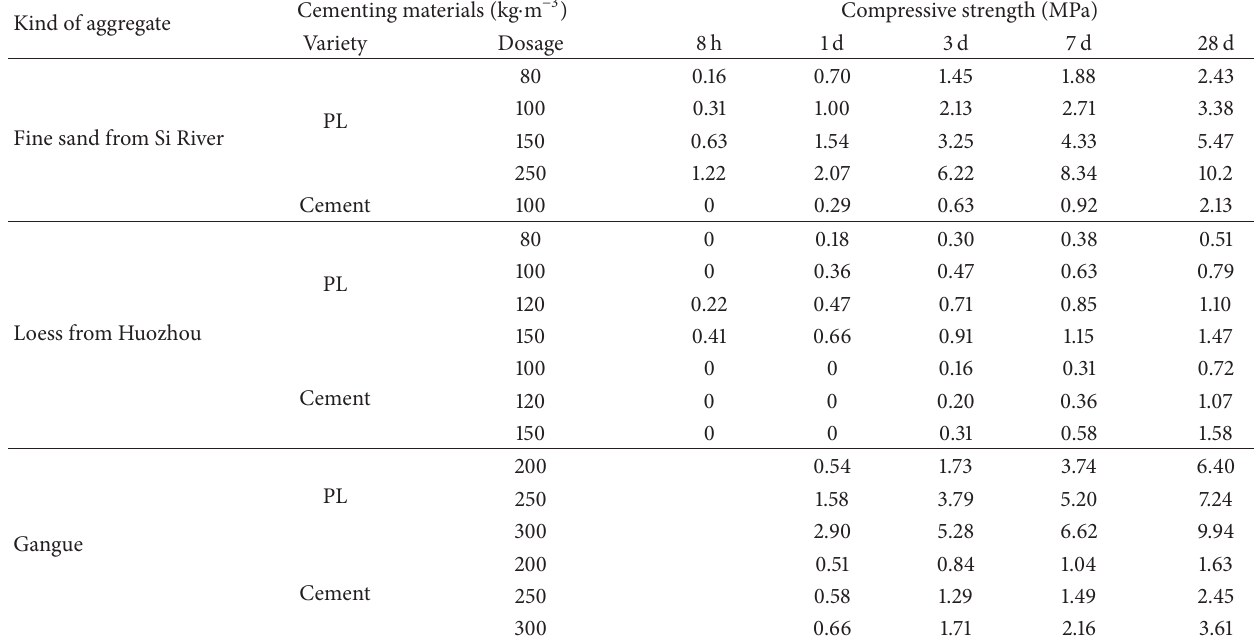
Table 1: Performance table of PL backfilling cementing materials and 42.5 level normal cement. Kind of aggregate